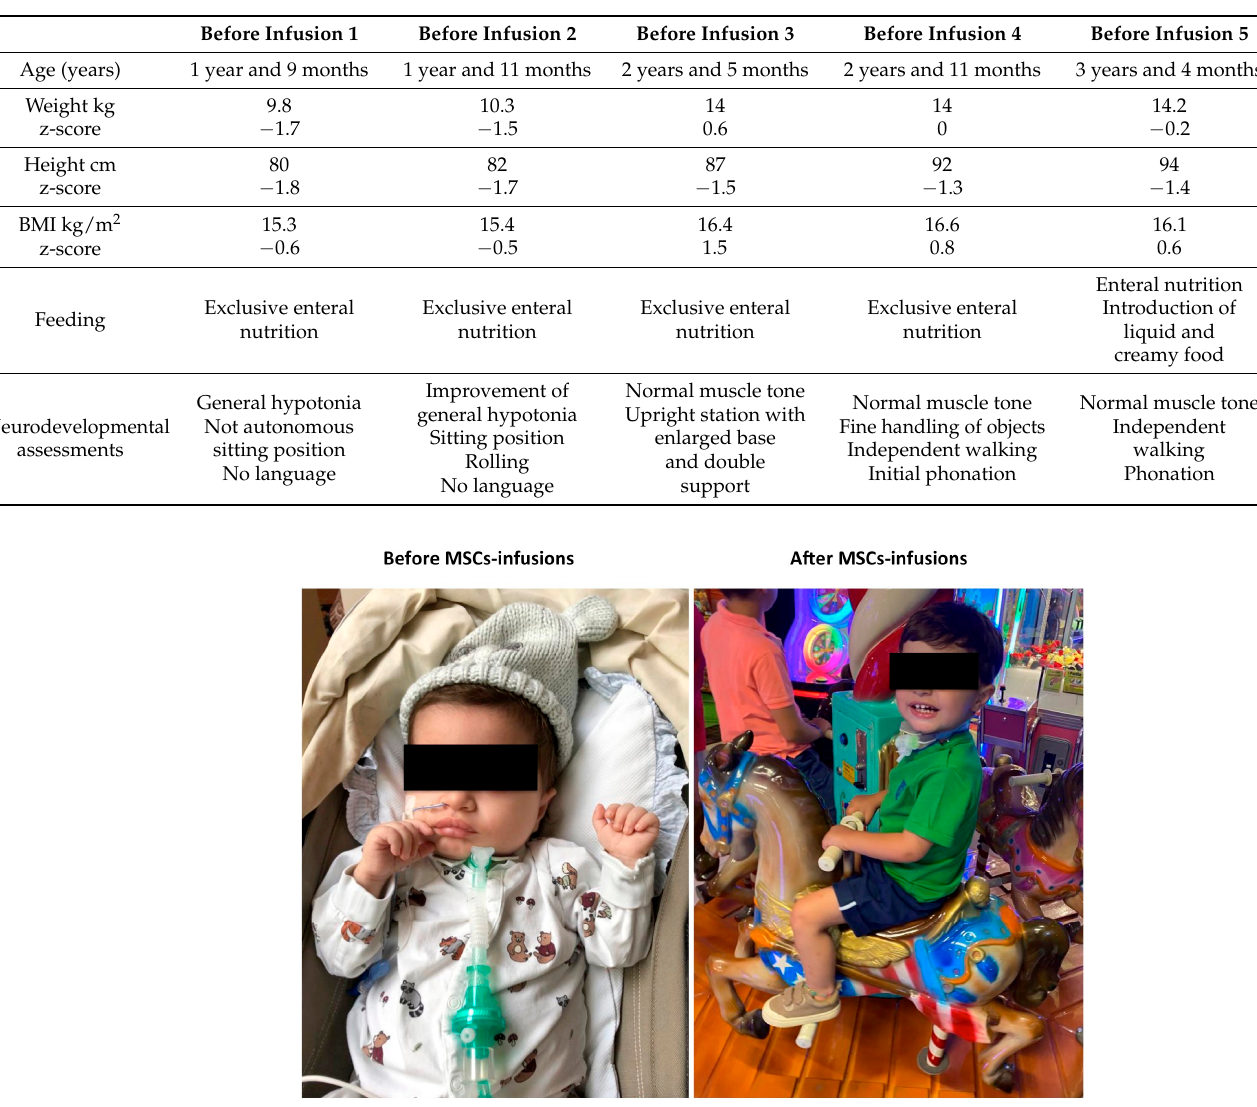
Table 2. Clinical parameters and nutritional support.